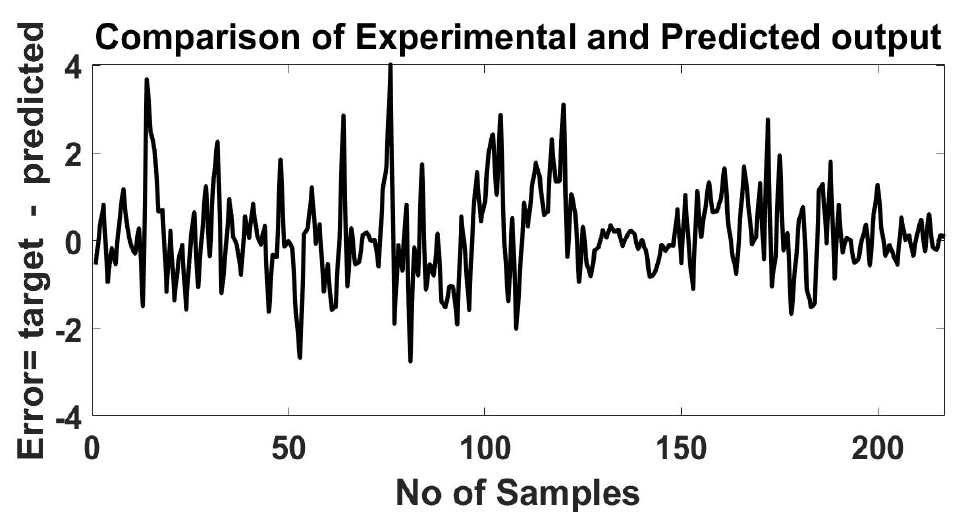
Figure 11. Error between predicted and targets by ANN.